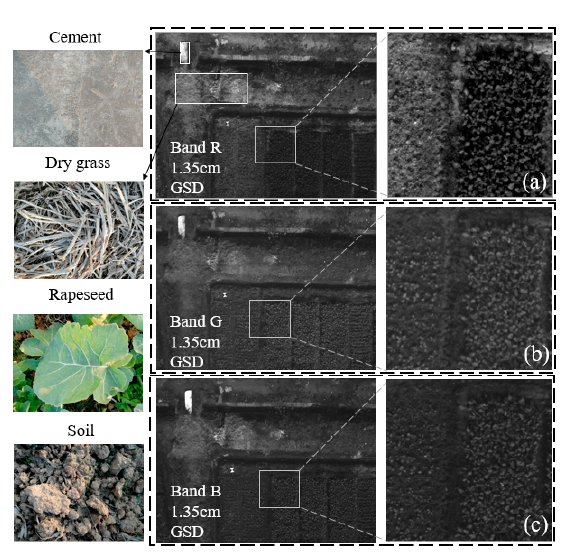
Figure 11. Visible band images at 1.35 cm GSD: ( a ) Red band; ( b ) Green band; ( c ) Blue band.